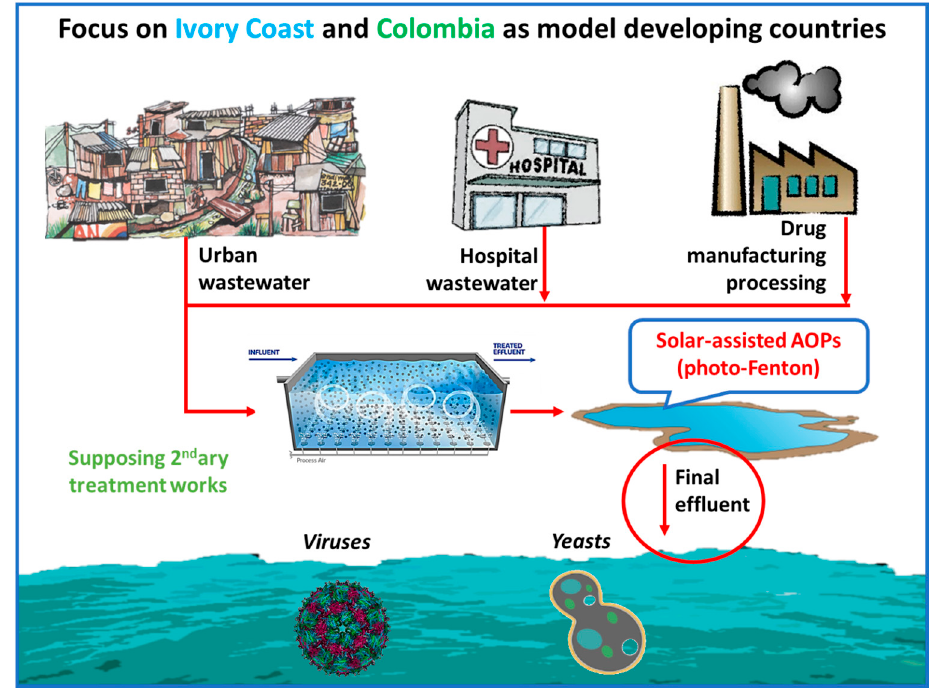
Figure 3. Schematic representation: Using the photo-Fenton as a disinfection method in developing countries. The application of Fenton reagents, aided by the numerous sunny days in the circum- Equatorial regions, which coincide with the geographical distribution of developing countries, was assessed on their virucidal and fungal inactivation capacities, using bacteriophages and common yeasts as proxies, while assessing the important role of dissolved organic matter and iron.